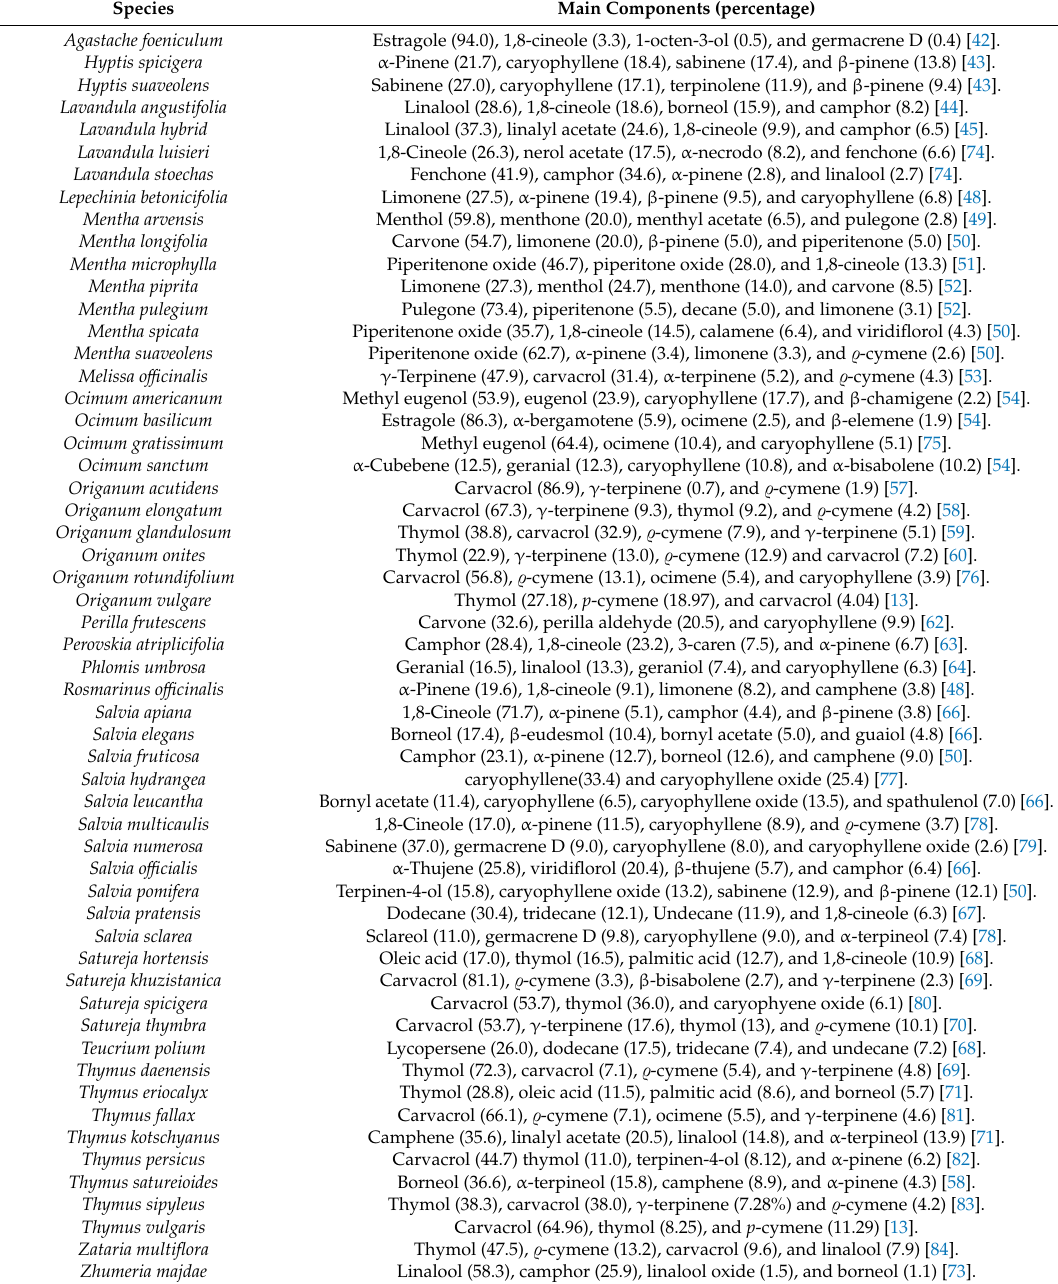
Table 2. Main components of the essential oils isolated from di ff erent species of the Lamiaceae plant family with pesticidal